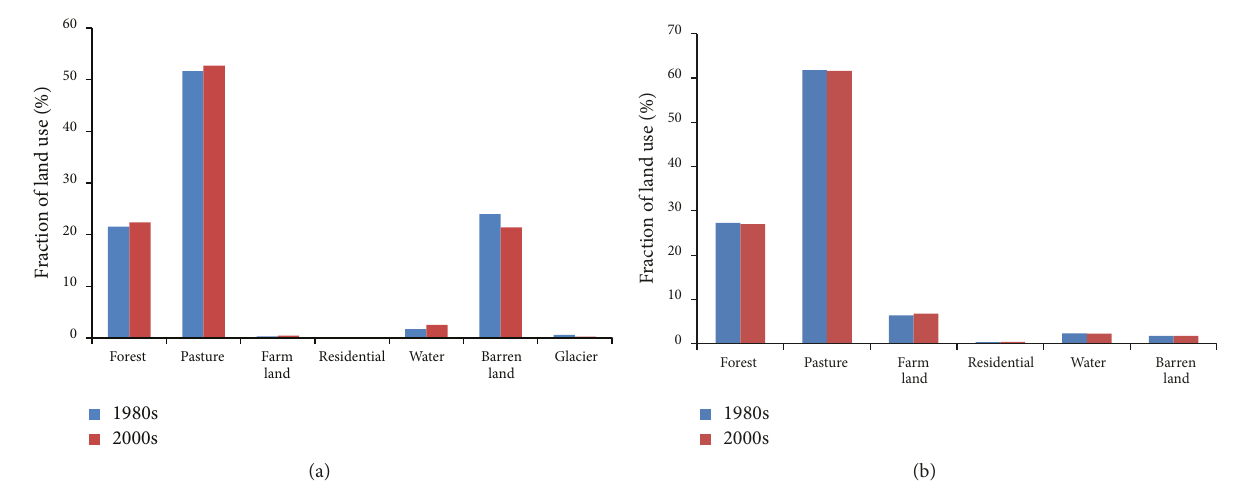
Figure 5: Fraction of land uses in YLC (a) and MXC (b) from 1980s to